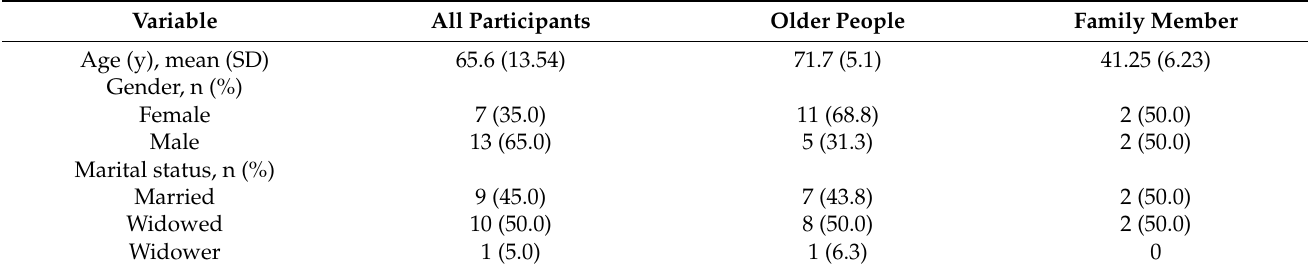
Table 1. Demographic characteristics of the participants.